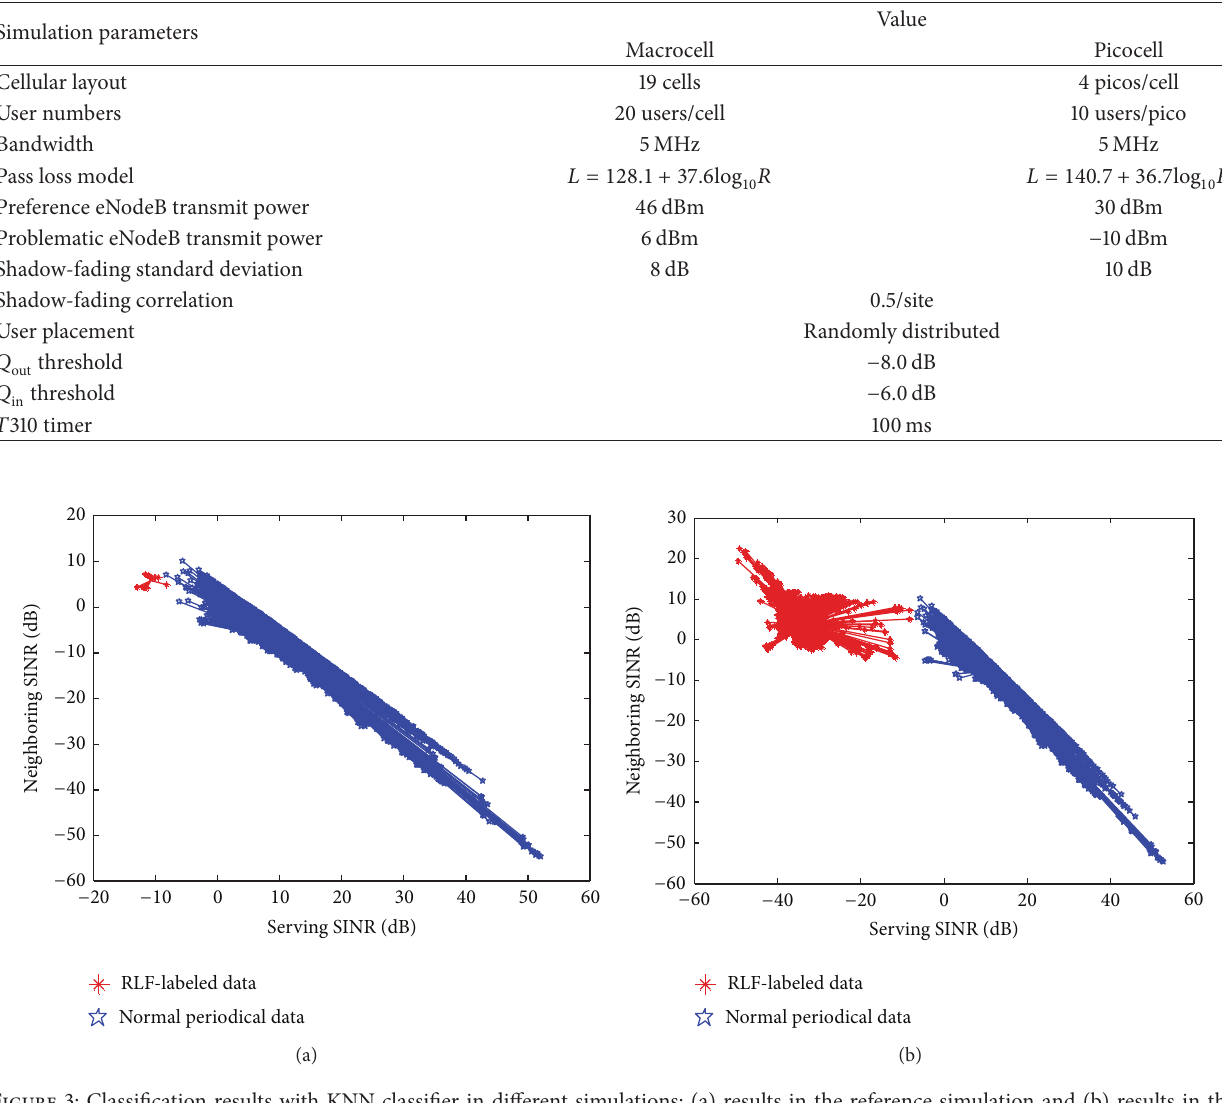
Table 1: Simulation parameters configuration.